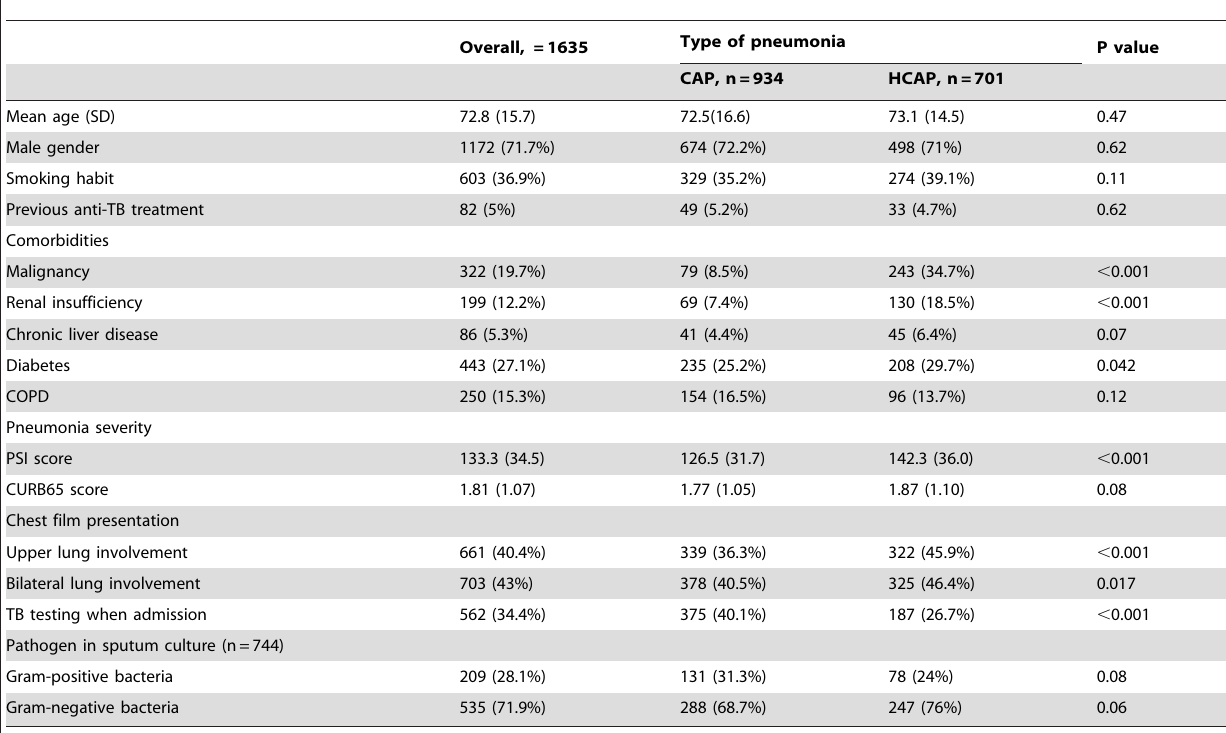
Table 1. Demographic profiles between hospitalized HCAP and CAP patients a